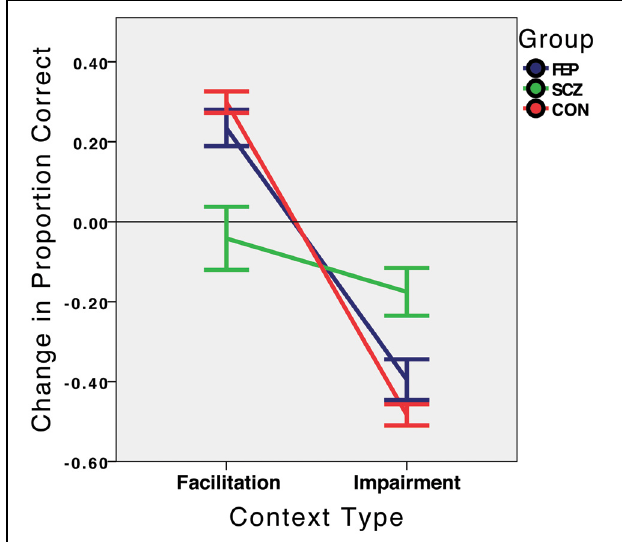
FIGURE 3 | Context sensitivity at Time 1 (hospital admission for the SCZ and FEP groups), by group. Performance in the facilitation and impairment context conditions is expressed relative to performance in the no-context condition, which is represented by the value 0.0 on the Y axis. FEP, First Episode Psychosis; SCZ, Schizophrenia (multiple episode); CON, Healthy